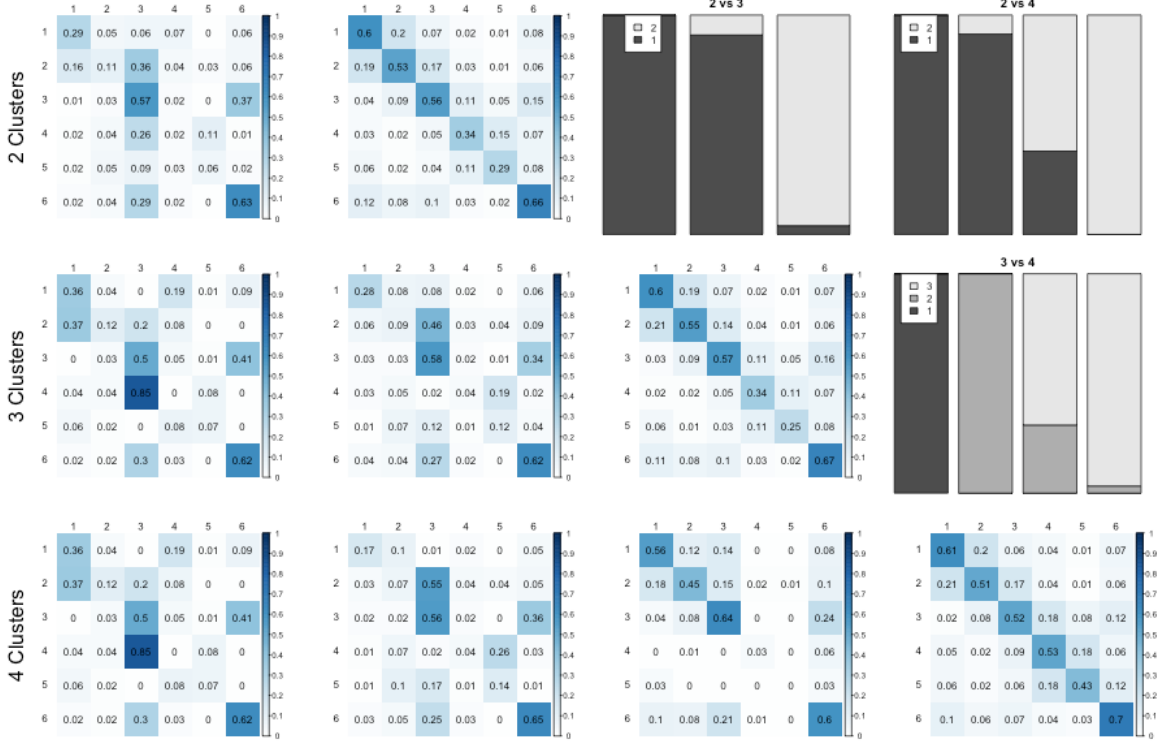
Figure 3. The cluster centers of the k- means solutions with two, three and four clusters, and the confusion counts of the different solutions. Each row corresponds to one solution (two, three, and four centers from top to bottom). The bars on top right of the Figure correspond to the overlap between cluster assignments. For example, panel 2 vs 3 indicates that most of the cases assigned to the first and second cluster in the three cluster solution were classified into the first cluster in the two cluster solution, whereas most of the cases classified into the third cluster with the three cluster solution were classified into the second cluster in the two cluster